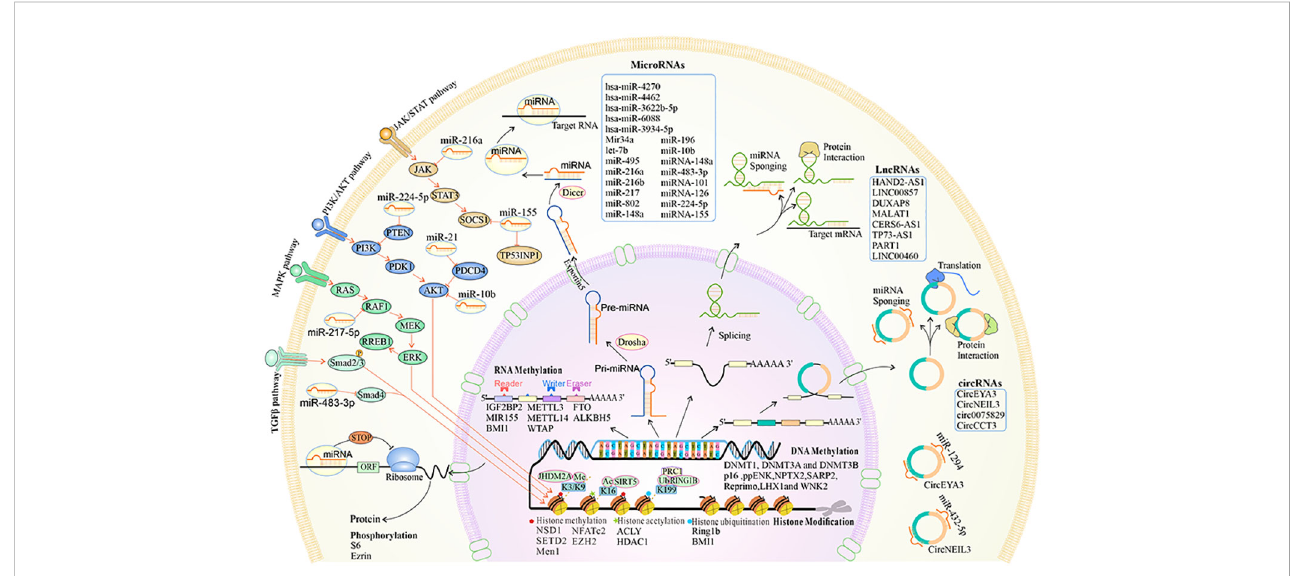
FIGURE 2 The overview of the biogenesis, functions, and mechanisms of epigenetic reprogramming in pancreatic premalignancy. At the chromatin level, histone methylation, acetylation and deacetylation, and histone ubiquitination occur. DNA and RNA can be modi fi ed by methylation. Alternative splicing leads to different isoforms of mRNA and proteins. MiRNAs can regulate different key downstream gene targets that mediate cellular signaling pathways. The lncRNAs are cell type-speci fi c and cell state-speci fi c. The lncRNAs can act as miRNA sponges, regulate mRNA stability, and interact with proteins. The circRNAs are transcribed by the RNA polymerase and can be processed through alternative splicing of the pre-mRNA. The circRNAs can act as miRNA sponges, interact with proteins, and translate into